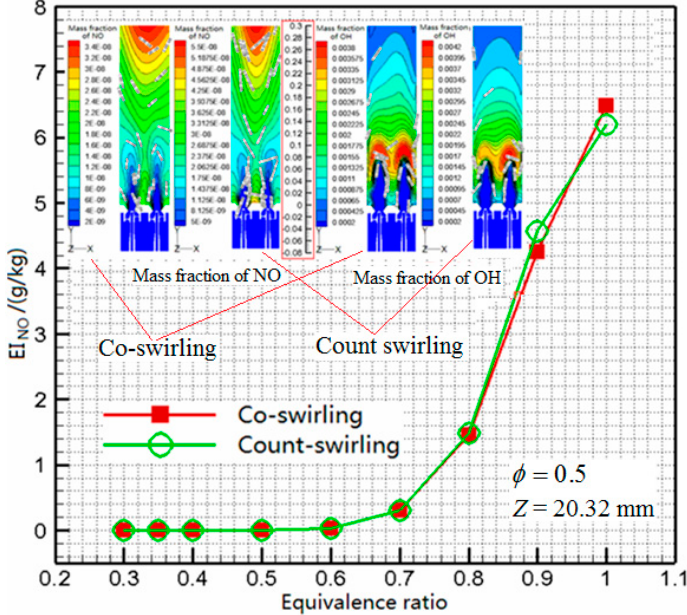
Figure 9. EI NO profiles compared between co-swirling and count-swirling four-point LDI combustors with different equivalence ratios.